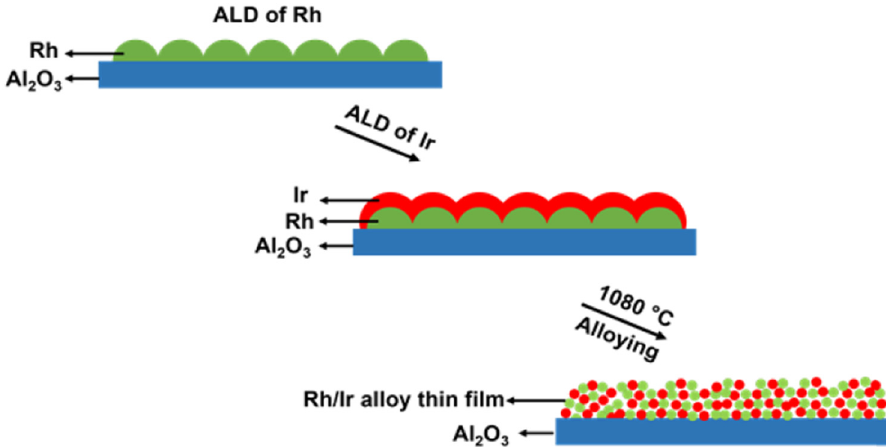
Figure 19: Schematic of the fabrication process of the thin fi lm alloy of Rh/Ir [ 191 ]